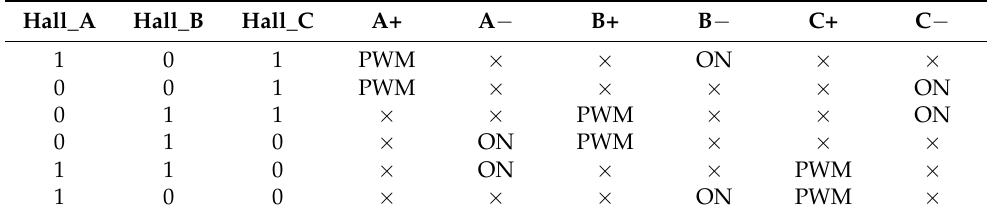
Table 3. Correspondence between Hall sensors and Mosfet switch